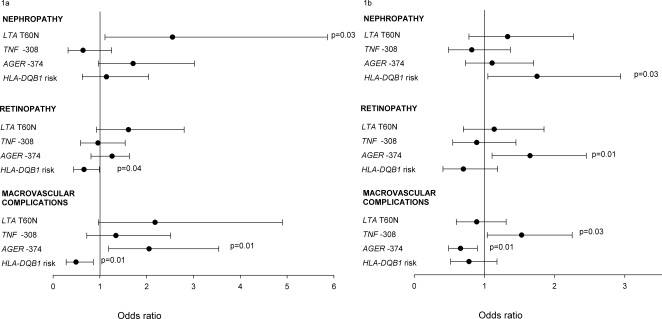
Logistic regression analysis in type 1 (1a) and type 2 (1b) diabetic patients with LTA T60N (C→A), TNF -308 G→A, AGER -374 T→A polymorphisms and HLA-DQB1 risk genotypes as independent and diabetic complication as dependent variable.Age, systolic and diastolic blood pressure, sex, previous/current smoking are included in all models. BMI is included in the models for nephropathy and macrovascular disease, duration in the models for nephropathy and retinopathy and age at diagnosis in the model for macrovascular disease.